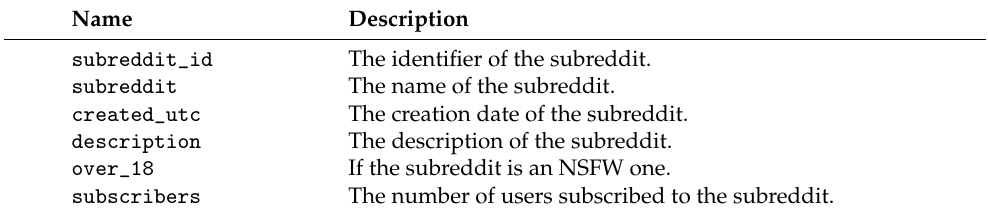
Table 3. The fields extracted for each